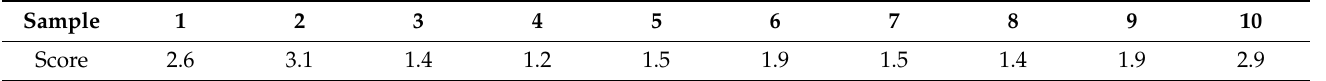
Table 6. Weight analysis data of 10